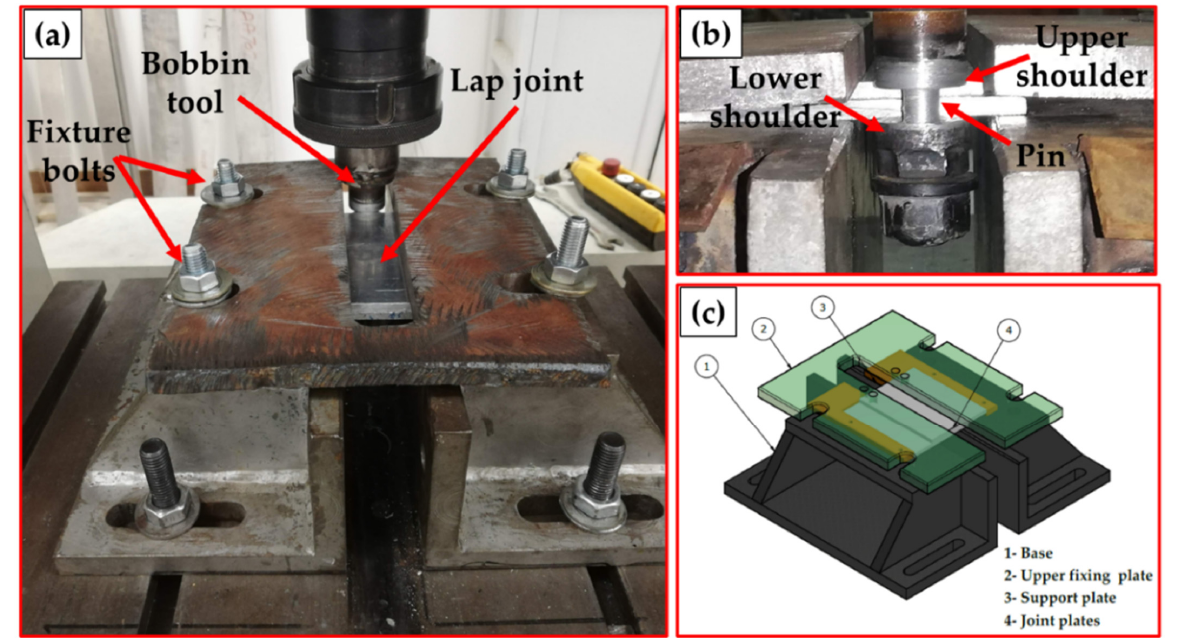
Figure 2. ( a ) Front photo and ( b ) back photo of BT-FSW of AA1050 thick lap joint. ( c ) 3D drawing of the used fixture system for BT-FSW process [9].